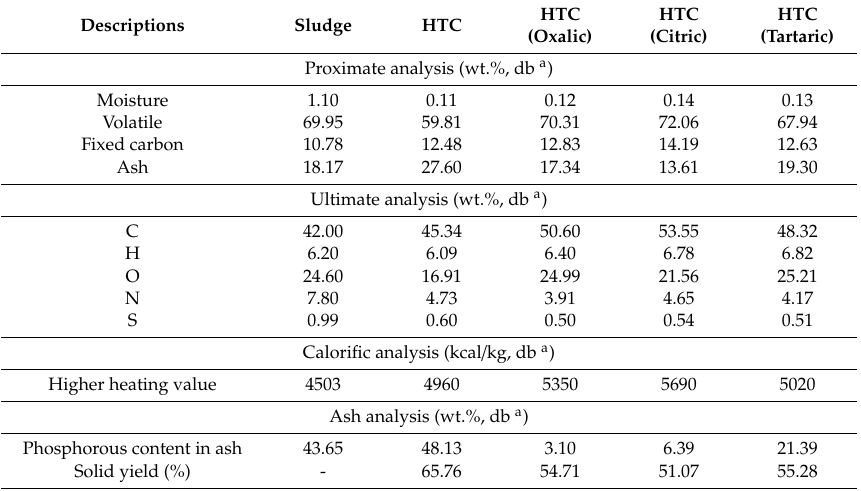
Table 1. Characteristic properties of the sludge, HTC, and HTC including organic